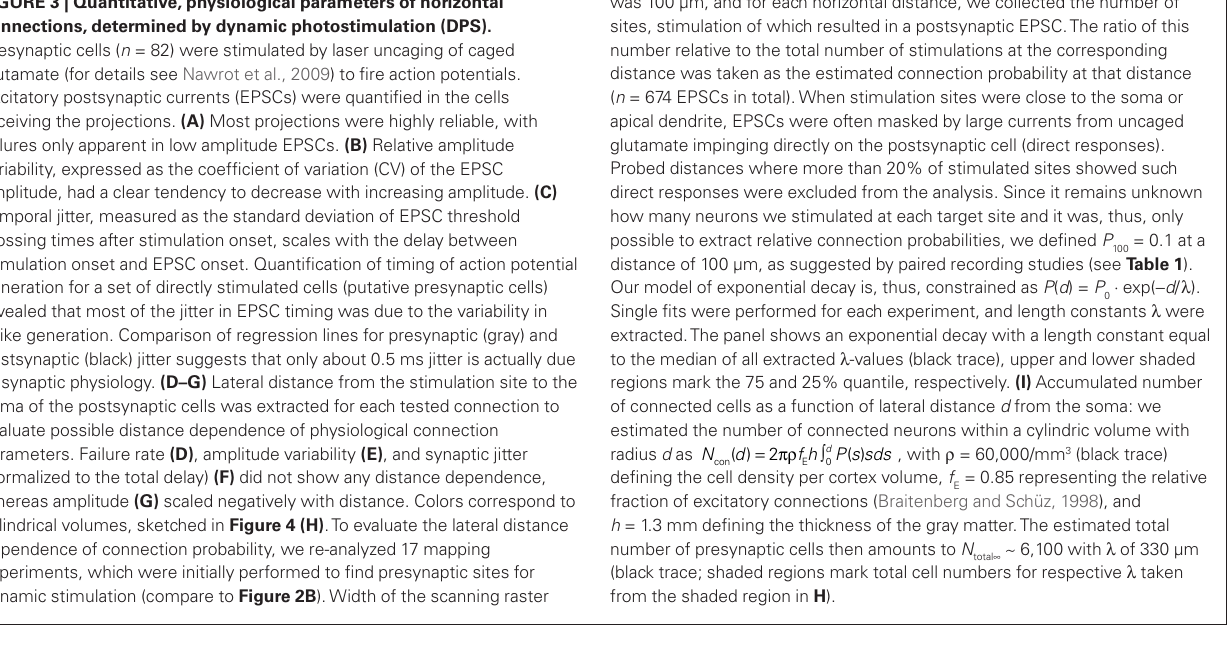
Figure 3 | Quantitative, physiological parameters of horizontal connections, determined by dynamic photostimulation (DPS). Presynaptic cells ( n = 82) were stimulated by laser uncaging of caged glutamate (for details see Nawrot et al., 2009) to fire action potentials. Excitatory postsynaptic currents (EPSCs) were quantified in the cells receiving the projections. (A) Most projections were highly reliable, with failures only apparent in low amplitude EPSCs. (B) Relative amplitude variability, expressed as the coefficient of variation (CV) of the EPSC amplitude, had a clear tendency to decrease with increasing amplitude. (C) Temporal jitter, measured as the standard deviation of EPSC threshold crossing times after stimulation onset, scales with the delay between stimulation onset and EPSC onset. Quantification of timing of action potential generation for a set of directly stimulated cells (putative presynaptic cells) revealed that most of the jitter in EPSC timing was due to the variability in spike generation. Comparison of regression lines for presynaptic (gray) and postsynaptic (black) jitter suggests that only about 0.5 ms jitter is actually due to synaptic physiology. (D–g) Lateral distance from the stimulation site to the soma of the postsynaptic cells was extracted for each tested connection to evaluate possible distance dependence of physiological connection parameters. Failure rate (D) , amplitude variability (e) , and synaptic jitter (normalized to the total delay) (F) did not show any distance dependence, whereas amplitude (g) scaled negatively with distance. Colors correspond to cylindrical volumes, sketched in Figure 4 (H) . To evaluate the lateral distance dependence of connection probability, we re-analyzed 17 mapping experiments, which were initially performed to find presynaptic sites for dynamic stimulation (compare to Figure 2B ). Width of the scanning raster